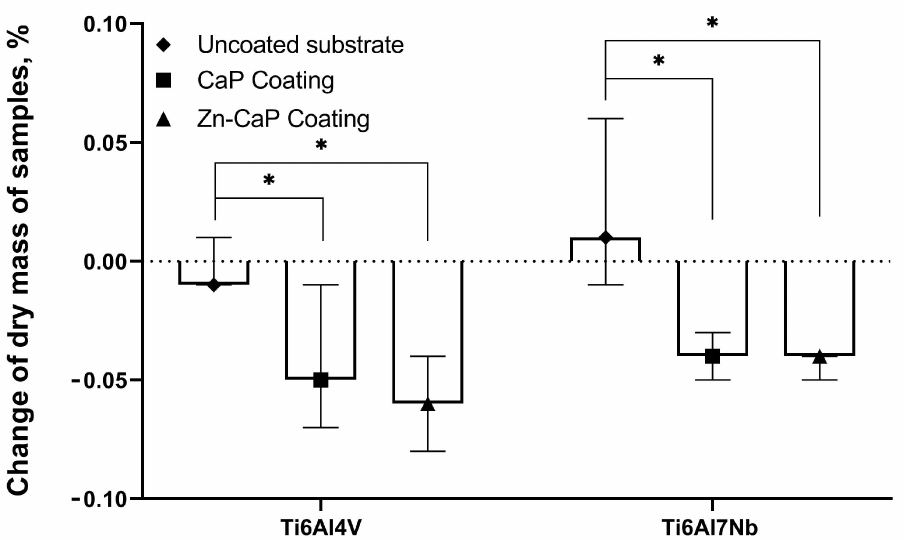
Figure 9. Weights of test samples before and after 5 weeks of immersion in 0.9% NaCl solution, Me (Q1–Q3). *—Statistical differences ( p < 0.05) with uncoated